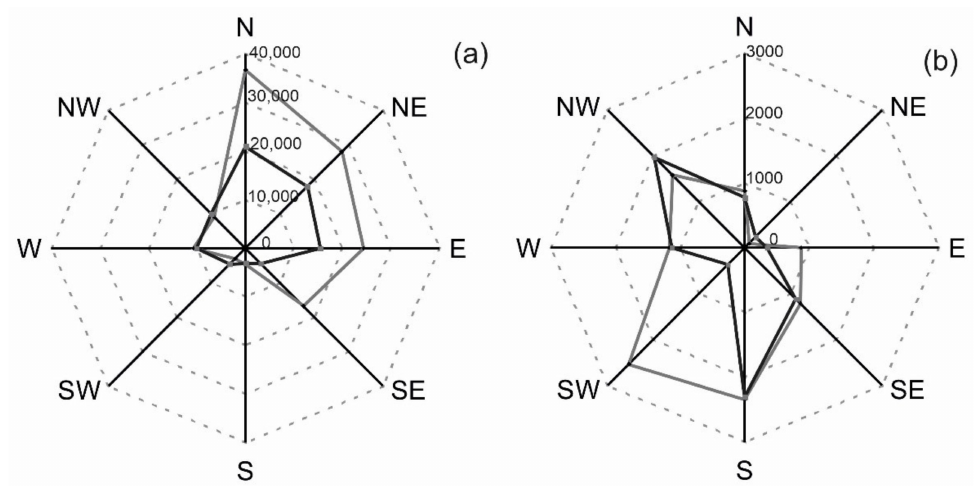
Figure 5. Number of pollen grains of triticale plants captured at different geographical directions in first ( a ) and second year ( b ), in border rows (black line) and spatial isolation (grey line). Please note the different scale of ( a , b )